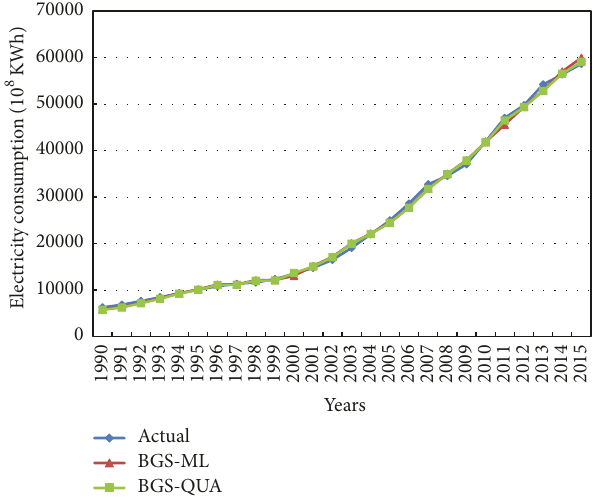
Figure 2: Comparison of actual and prediction values of electricity consumption (1990–2015).